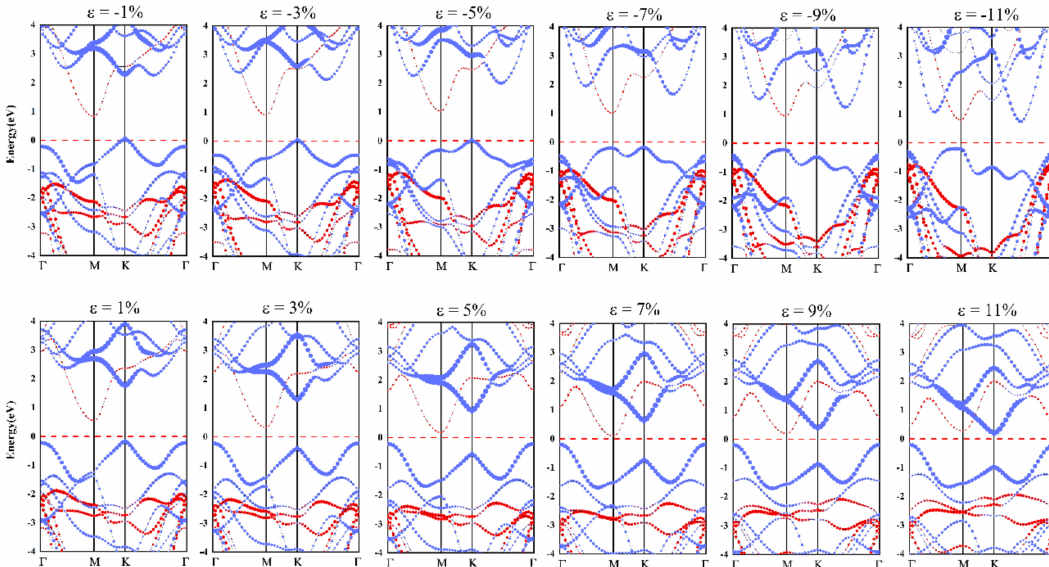
Figure 5. Projected band structures obtained by the HSE06 method under di ff erent in-plane biaxial stresses; red and blue lines are bands contributed by SnS 2 and WSe 2 ,